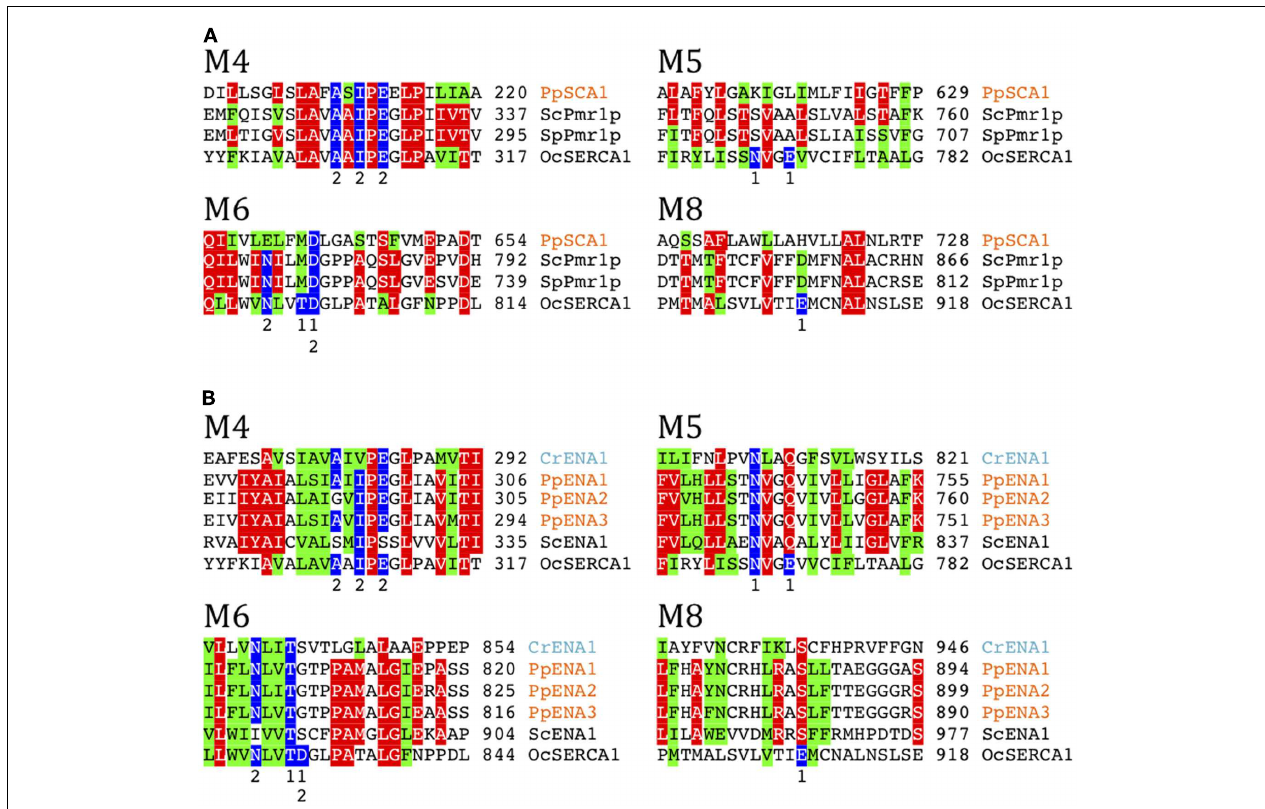
a conserved Asp in M6. Fungal examples shown are S. cerevisiae Pmr1p (P13586) and S. pombe Pmr1p (O59868). (B) P2D ATPases (ENA pumps) do not have a conserved Asp in M6 like all other P2 ATPases. Residues contributing with Ca 2 + coordinating oxygen molecules in rabbit SERCA1 (Toyoshima et al., 2000) are marked in blue. Only sequences including the predicted transmembrane segments M4, M5, M6, and M8 are